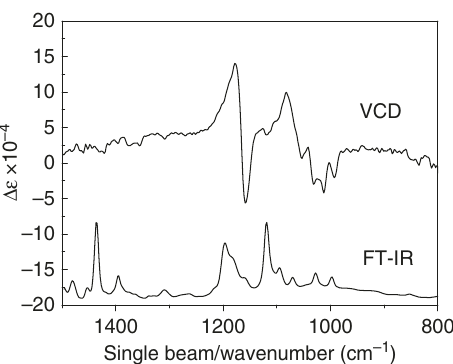
Fig. 5 FT-IR and VCD spectra of the Ag 23 nanocluster. The IR peaks at 1179 and 1159 cm − 1 and 1082 and 1012 cm − 1 are assigned to the Ag – S – C and Ag – P – C stretching modes, respectively